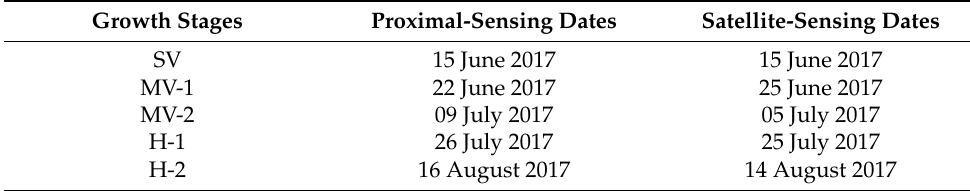
Table 1. Acquisition dates of satellite and proximal-sensing